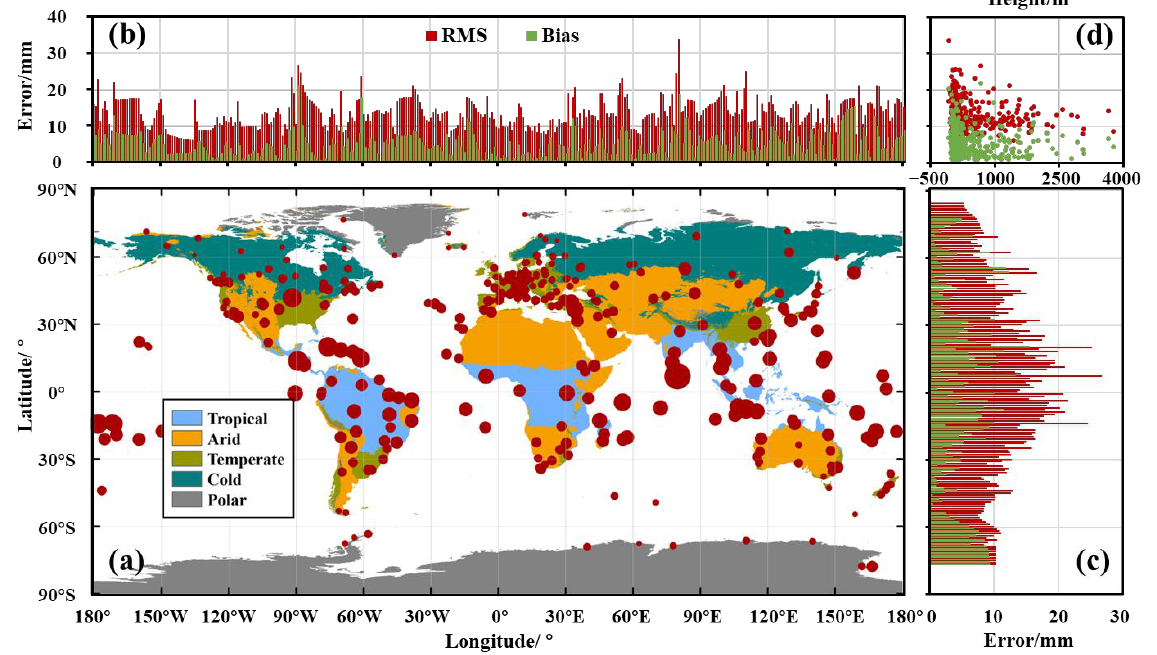
Figure 9. Climate classification and distribution of tropospheric delay errors in the ERA5 inversions: ( a ) global Köppen–Geiger climate classification and ZTD RMS error distribution for the ERA5 inversions (the size of the points represents the size of the RMS); ( b ) variation in the ZTD bias and RMS with longitude from the ERA5 inversions (after linear interpolation in 1° longitude); ( c ) variation in the ZTD bias and RMS with latitude from the ERA5 inversions (after linear interpolation at the 1° latitude); ( d ) variation in the ZTD bias and RMS with height from the ERA5 inversions.